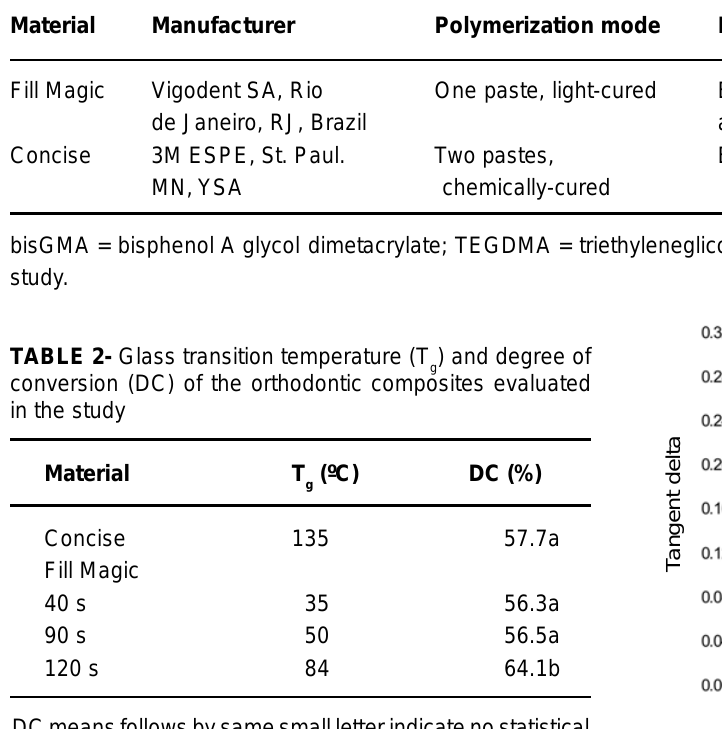
DC means follows by same small letter indicate no statistical difference by the Tukey’s test at 5% of probability.